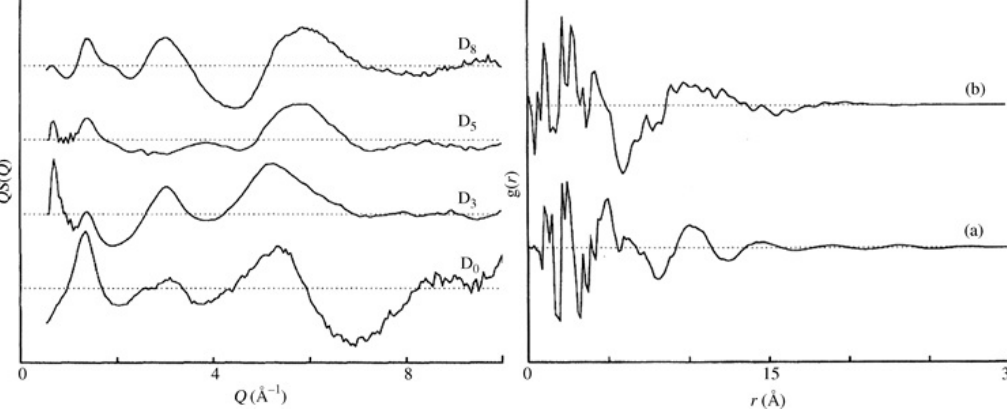
Figure 2. Structure factors (left) and radial distribution functions (right) for selectively deuterated glassy polystyrene. The level of deuteration can be assessed by the number next to the label B (see text for full details). (a) indicates the total correlation function for system D 8 and (b) the partial correlation function g bb describing the correlations involving only the backbone atoms. Both graphs were reproduced from reference [2].